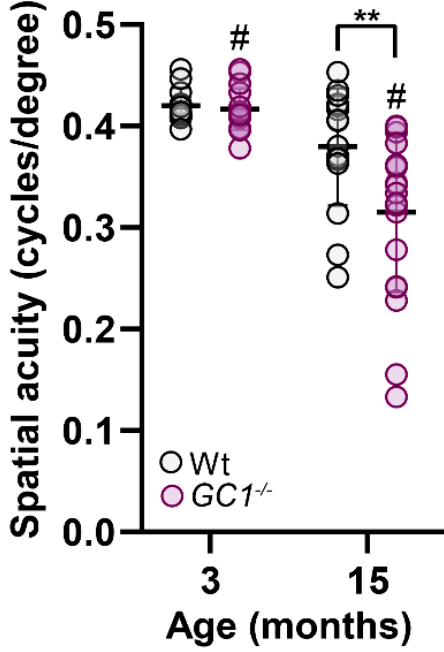
Figure 7. Visual acuity is decreased with age in GC1 − / − mice. Visual acuity in Wt mice does not significantly decline with age (3 m; n = 6 and 15 m; n = 8), however, GC1 − / − visual acuity significantly declines (3 m vs. 15 m, n = 10 and n = 8 # p < 0.0001; Kruskal–Wallis one-Way ANOVA). GC1 − / − have similar acuity to Wt mice at 3 months ( n = 10), which declines significantly at 15 months compared to Wt mice ( n = 10; ** p = 0.02; Kruskal–Wallis one-Way ANOVA). Data points represent independent acuity readings in each naïve eye and are plotted as means ± S.D.